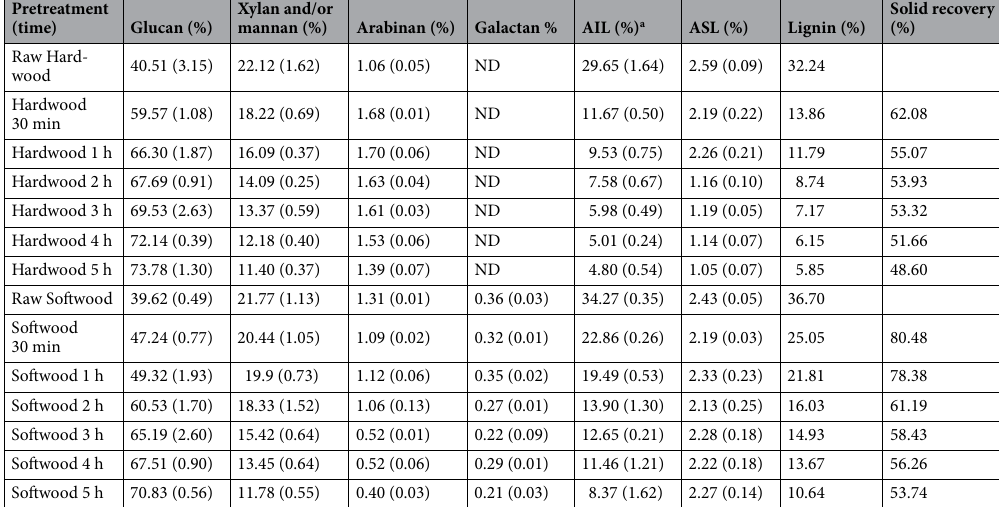
Table 1. Biomass composition of untreated and acid pretreated hardwood and softwood biomass during thermally-assisted pretreatment. Here, Lignin % = acid insoluble lignin (AIL %) + acid soluble lignin (ASL %) and ND not detected. The parentheses contain the standard deviation with the analysis repeated